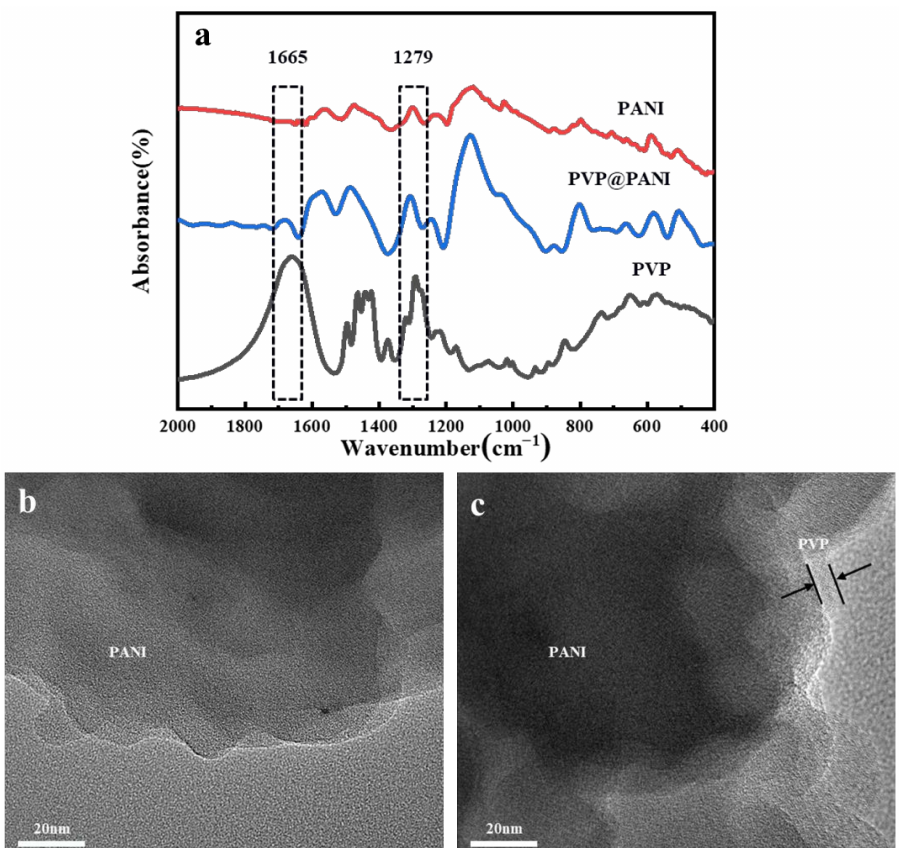
Figure 2. Infrared spectra of PANI, PVP@PANI, and PVP ( a ). TEM images of PANI ( b ) and PVP@PANI ( c